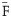
A. Model of the PV-SST-Exc circuit (spiking model, where connection strengths are given by conductances gij. Note that the conductances with subscripts gij are distinct from g(t), the adaptation variable for the thalamic input. The rate model uses connection strengths wij). B. Input and response profiles for the single-unit rate and spiking model to a 100 ms long tone. Top: Gray: thalamic depression variable g. Blue: excitatory (Exc) neuron activity. Cyan: PV. Magenta: SST. Bottom: Thalamic input (red). C. Responses to stimulus over the first 30 s after sound onset for the different paradigms modeled in the paper. We used a high and a low inhibition mode of synaptic weights to capture the different results. For SSA (black) and forward suppression (FWS, gray), the variable F¯ is higher than threshold F¯Th, resulting in a set of low inhibition parameters. Paradigms for tuning-curve adaptation (purple) and PV activation (g) asymptote at below-threshold levels, resulting in a set of high inhibition parameters. D-G responses of neurons in the spiking model to a 50ms tone. Top: raster plot; Bottom: Firing rate of Exc (D), PVs (E), SSTs (F), and thalamo-cortical input (G).